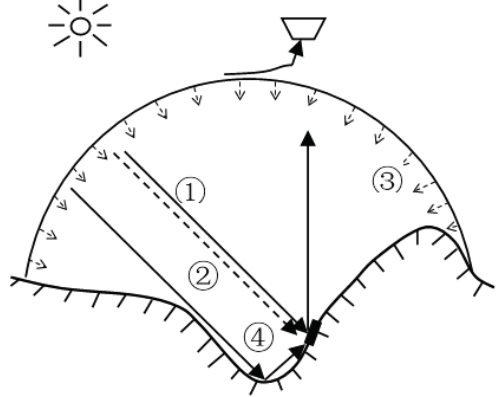
Figure 2. Solar irradiance on an inclined surface: (1) direct; (2) anisotropic diffuse; (3) isotropic diffuse; and (4)